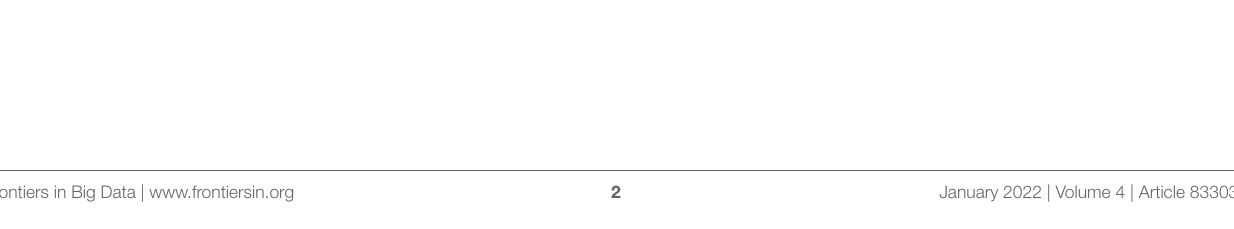
Frontiers in Big Data |